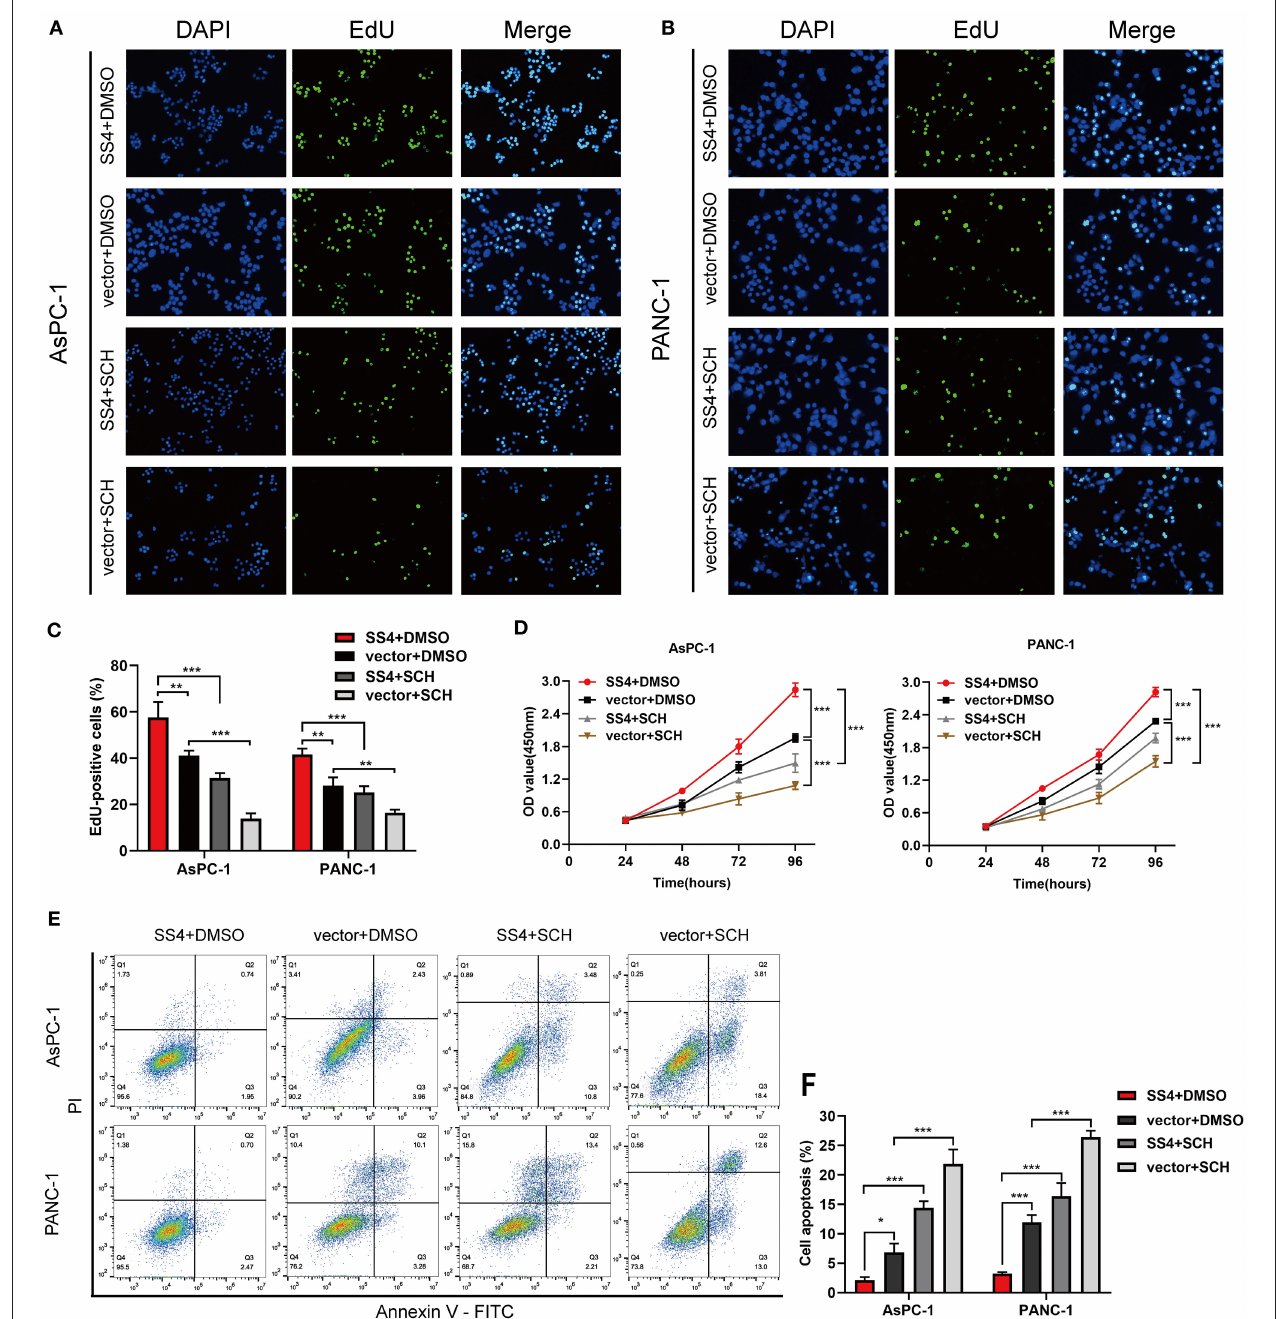
FIGURE 5 | The ERK1/2 signaling pathway is essential for TMPRSS4-induced proliferative and apoptotic behavior of cells in vitro . AsPC-1 and PANC-1 cells with stable TMPRSS4 overexpression and the control cells treated with the specific ERK1/2 phosphorylation inhibitor: SCH772984 (2mM), or the same volume of DMSO for 24h. (A–C) The representative fluorescent micrograph and quantification of the EdU staining of indicated cells. (D) The CCK-8 growth curves of indicated cells. (E,F) Cell apoptosis analyzed by flow cytometry. Each bar represents the mean ± SD of three independent experiments. Student’s t -test (for two groups) or ANOVA with Turkey’s method (for several groups) were used for comparisons. Paired Student’s t -test was applied. * P < 0.05; ** P < 0.01; *** P < 0.001; SS4, transmembrane protease serine 4; SCH, SCH772984; vector, vector-only control; DMSO, Dimethyl Sulfoxide; PI, Propidium Iodide; FITC, Fluorescein Isothiocyanate.